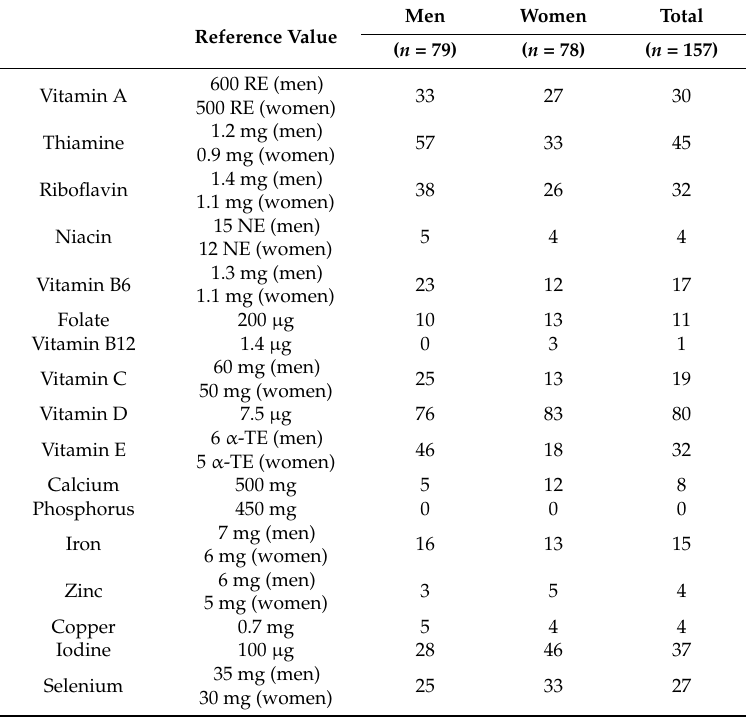
Table 4. Percentage of study population with intakes below the estimated Average Requirements (AR) for selected